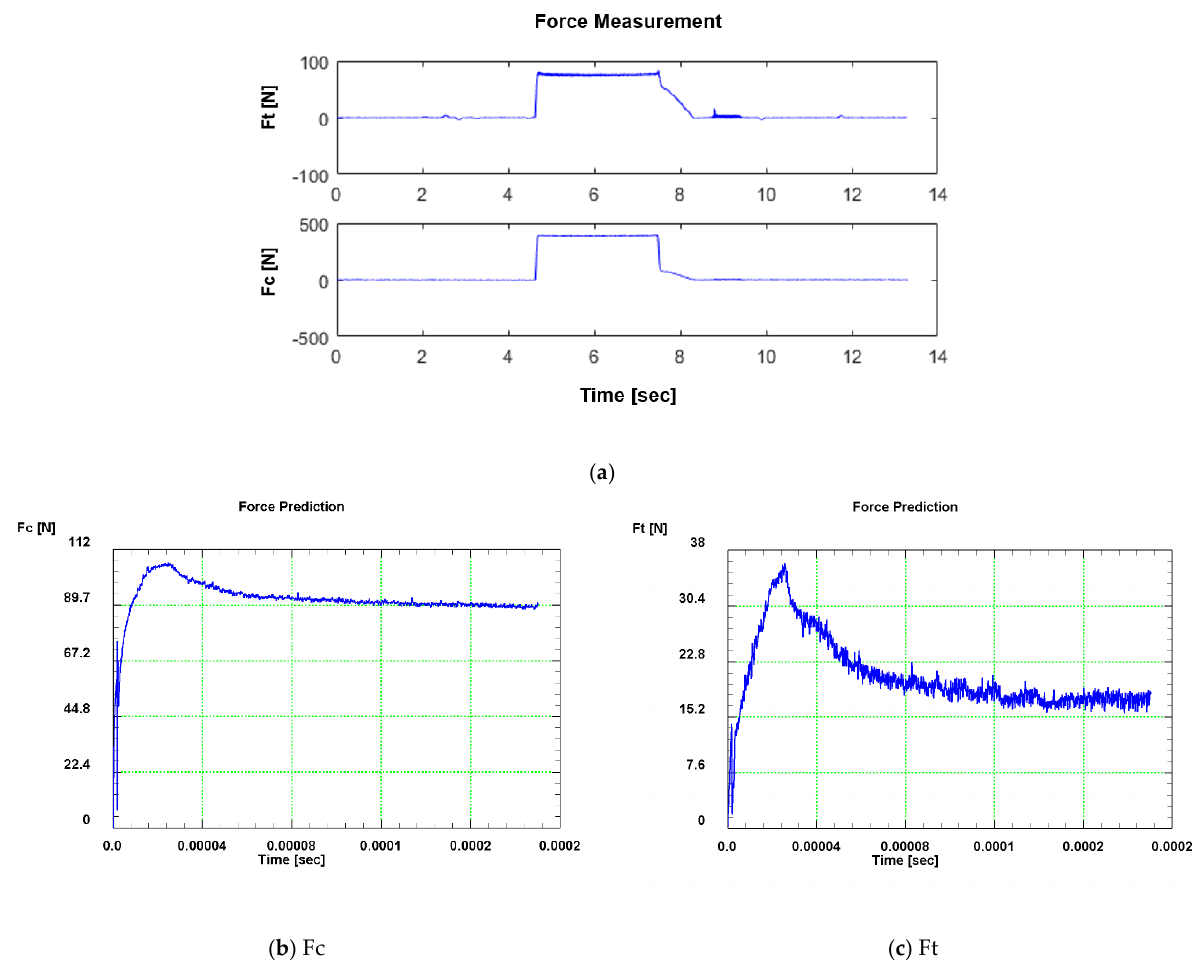
Figure 16. Variation of cutting and thrust forces with time during flood-coolant orthogonal cutting: ( a ) in the experiment (force signals) for the 4 mm width of cut and ( b , c ) in FE modeling for the unit width of cut.